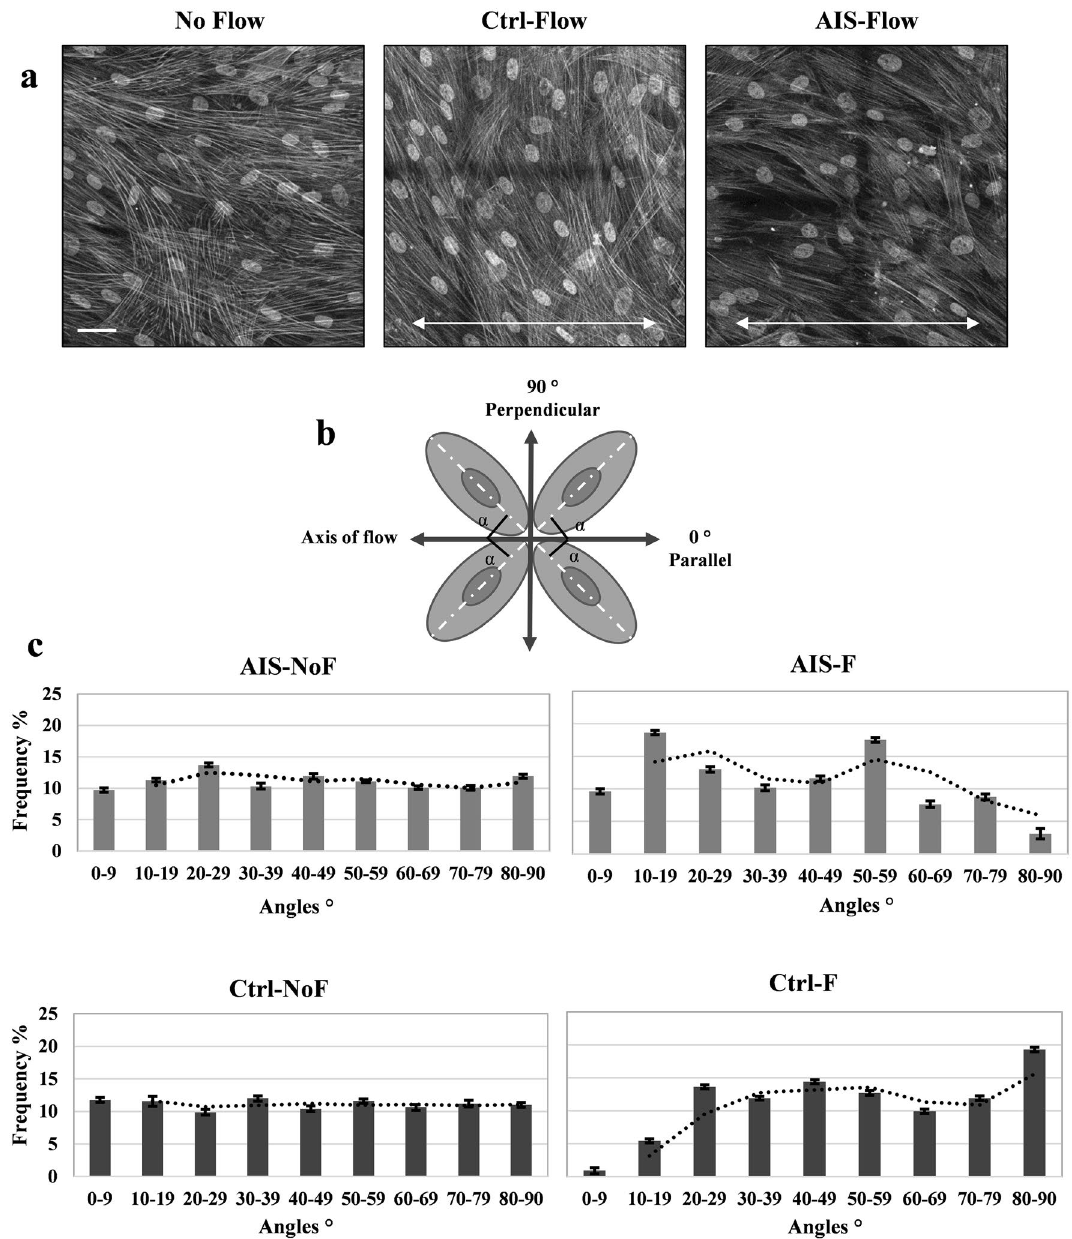
Figure 4. Cellular orientation adjustment relative to direction of flow varies between control and AIS primary osteoblasts. ( a ) Grayscale immunofluorescence micrographs (Objective 63 oil) of stained nucleus and actin F filaments, to show how the cells orient themselves relative to the axis of flow (20 h), in 4 fields of view for each sample. Cell samples from 4 control and 4 AIS patients were studied (n = 4 per group). White scale bar, 25 µm. Two headed white arrows show the direction of oscillatory fluid flow application. ( b ) For each sample 500–750 angles between the longest axis of the nucleus and axis of flow (α) were measured in 5 × 4 tile images (20 fields of view) as shown in this schematic figure (adapted from Yao and Wong (2015) Cells. J. Biomech. Eng. 137, 020,907). ( c ) Data represents the frequency of cellular alignment distribution in percentage after 20 h of 1 Hz flow application. Trend line of moving average is shown as dotted lines.